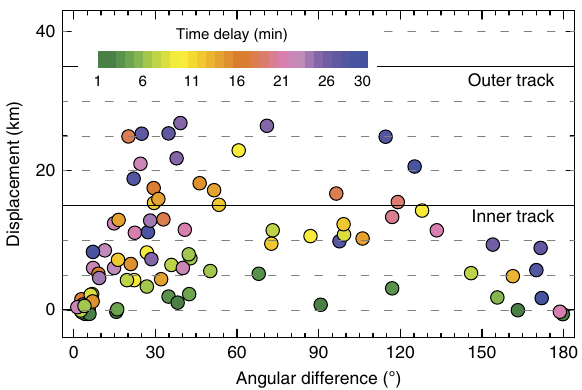
Figure 5 | Cirrus cloud optical thickness per category for a maximum cirrus geometrical depth of 2.5km. The magenta box-and-whisker plots show the quantiles for the data in each category from a one-way analysis of variance using the JMP software package. Mean diamonds (cyan) indicate the 95% confidence intervals for the mean values of each of the categories. If the upper and lower horizontal lines overlap, there is no statistically significant difference in means. Numbers in the lower part of the figure give the mean value and number of observations (that is, CALIPSO L2 5-km points) in each category. The horizontal grey line represents the overall mean value. Table 1 | Statistical significance between all categories pairs with P r 0.05, subdivided with respect to maximum cirrus geometrical depth.